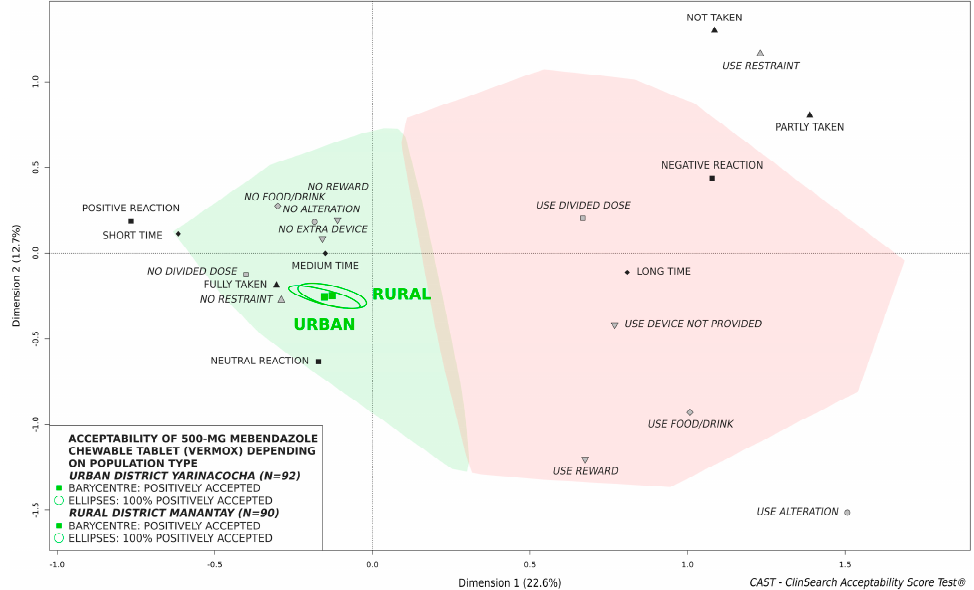
Figure 6. Influence of location on acceptability of 500-mg mebendazole chewable tablet in children aged 2 to 4 years.